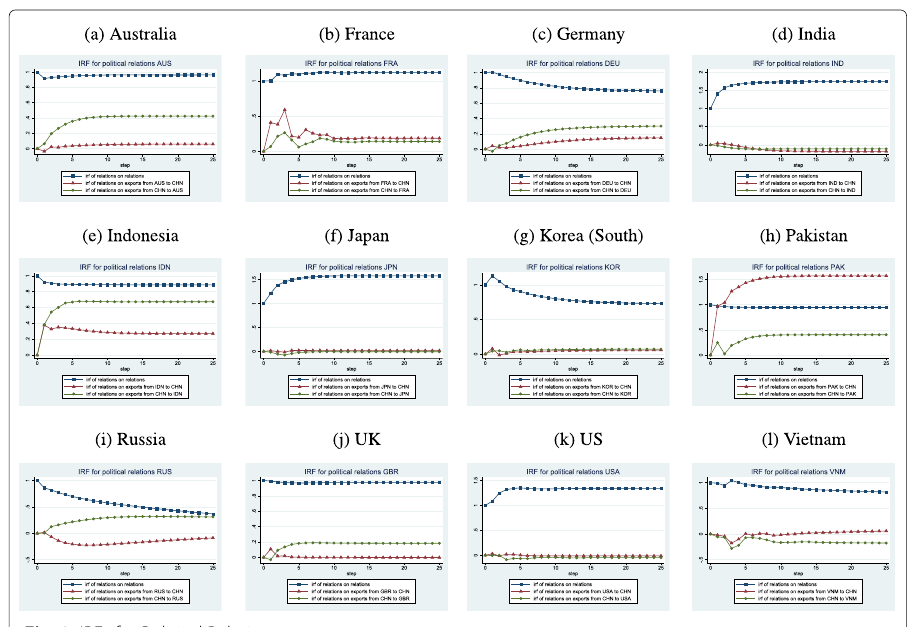
Fig. 2 IRFs for Political